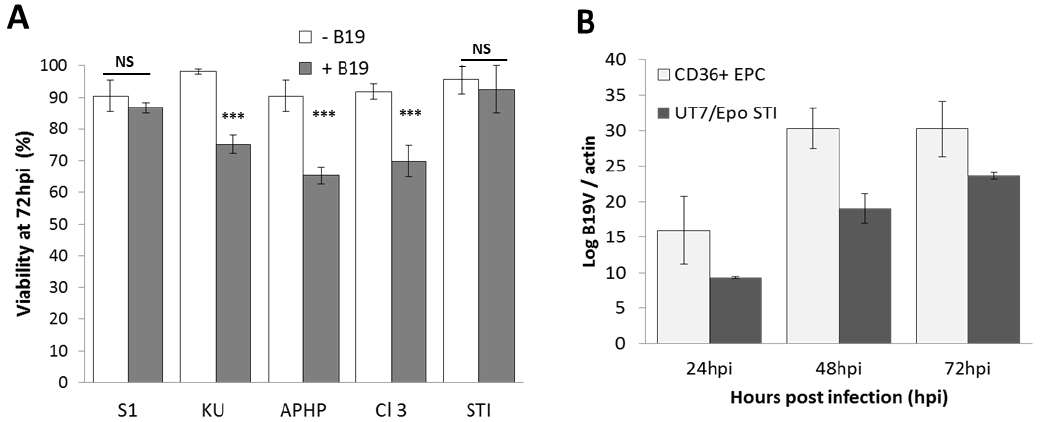
Figure 2. Comparison of B19V sensitivity of hematopoietic cell lines. ( A ) Cell viability was assessed 72 h post-infection. The results shown are the means + SD of three independent experiments. ( B ) UT7/Epo-STI cells and CD36 + EPCs were cultured in triplicate, with or without B19V, for 72 h. At 24, 48 and 72 h post-inoculation, cells were collected by centrifugation. RNA was extracted from the cell pellet and VP2 mRNA levels were analyzed to quantify B19 viral DNA expression, and β -actin mRNA levels were analyzed for cell number normalization. For each cell line, results without B19V correspond to the negative control. Relative B19V threshold cycle (Ct) values were normalized relatively to the β -actin (log B19V / actin). The results shown are the means + SEM of three independent experiments. * p <0.05; ** p <0.01; *** p <0.001; NS = No Significance.